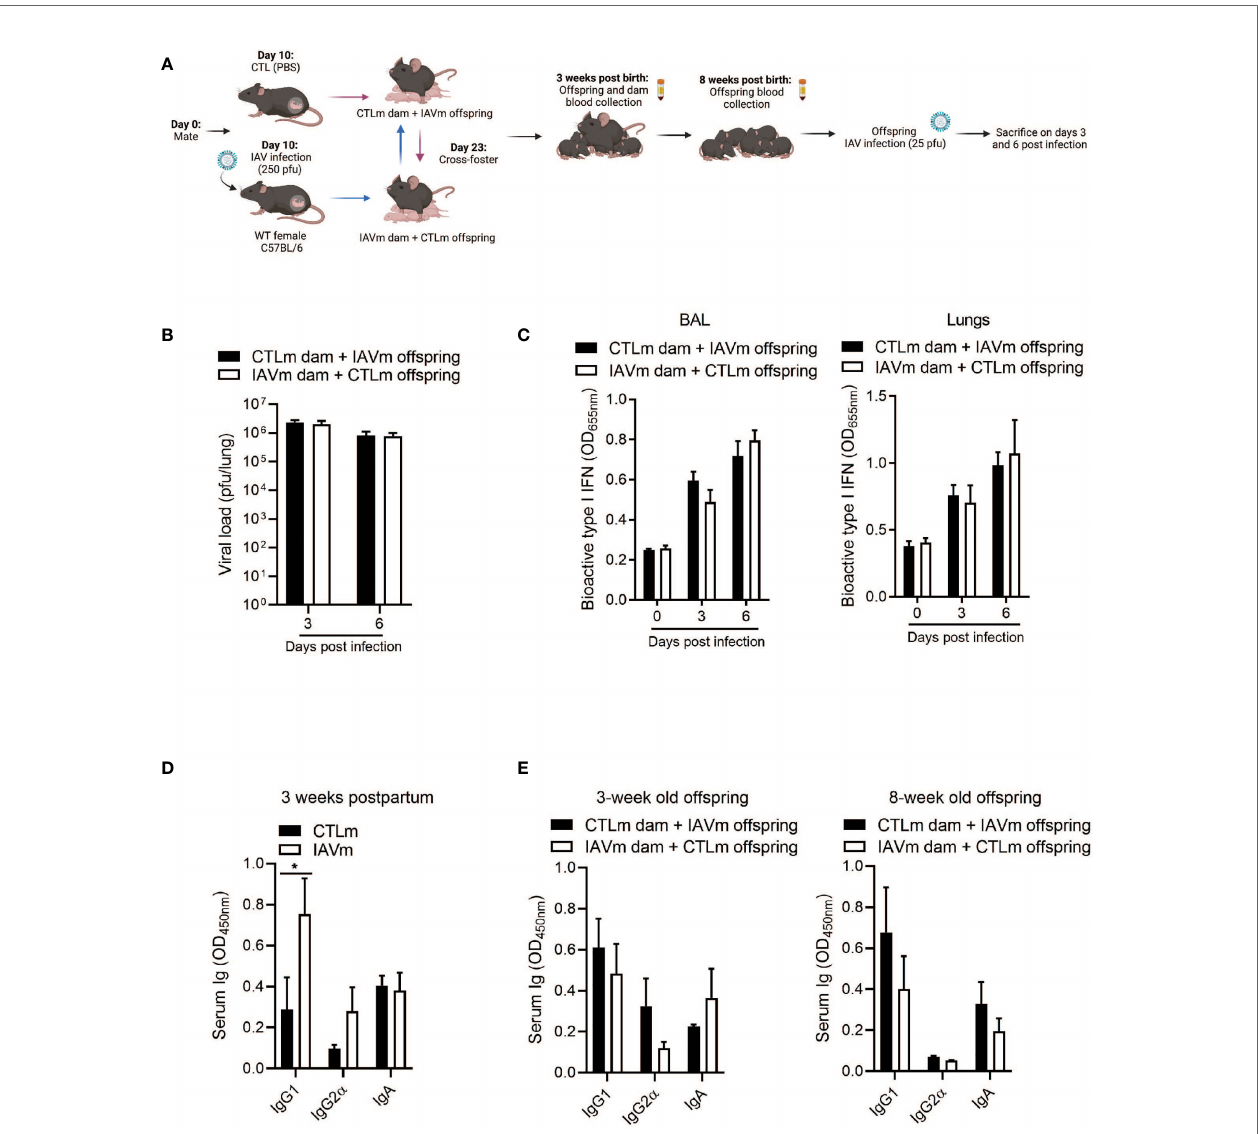
FIGURE 3 | Antibodies transferred solely through placenta or colostrum are insuf fi cient in conferring prolonged protection to offspring against IAV infection. (A) Schematic representation of experimental design. 8 – 10-week-old C57BL/6 females were given PBS (CTLm; n=3 dams) or infected with 250 pfu PR8 (IAVm; n=3 dams) intranasally on E10. Three days after birth, pups were cross-fostered. Created with BioRender.com (B) Kinetics of viral load in whole lung homogenates by MDCK assay (n=4-8 offspring) and (C) type I IFNs in BALF and lungs by B16 assay of 8-week-old offspring born to IAV dams and fostered by control dams (CTLm dam + IAVm offspring) and of offspring born to control dams and fostered by IAV dams (IAVm dam + CTLm offspring) infected with 25 pfu PR8 (n=4-6 offspring). (D) Serum antibody levels of control and IAV-infected dams 3 weeks postpartum (n=3). (E) Serum antibody levels of naïve cross-fostered offspring at 3 weeks and 8 weeks of age prior to secondary infection (n=4-6 offspring). Data pooled for male and female offspring. Two-way ANOVA *p<0.05. License acquired for schematics from